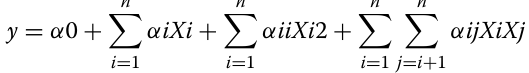
SD from three independent experiments ±